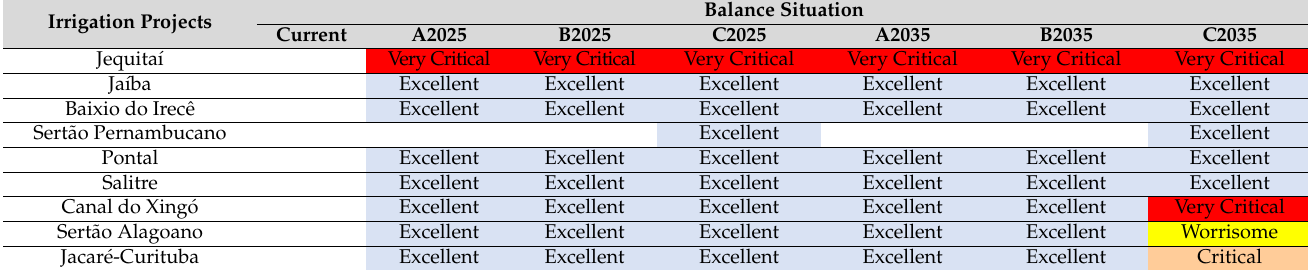
Table 11. Synthesis of the surface water balance (Acquanet)—large irrigation projects. See Table 3 for the corresponding